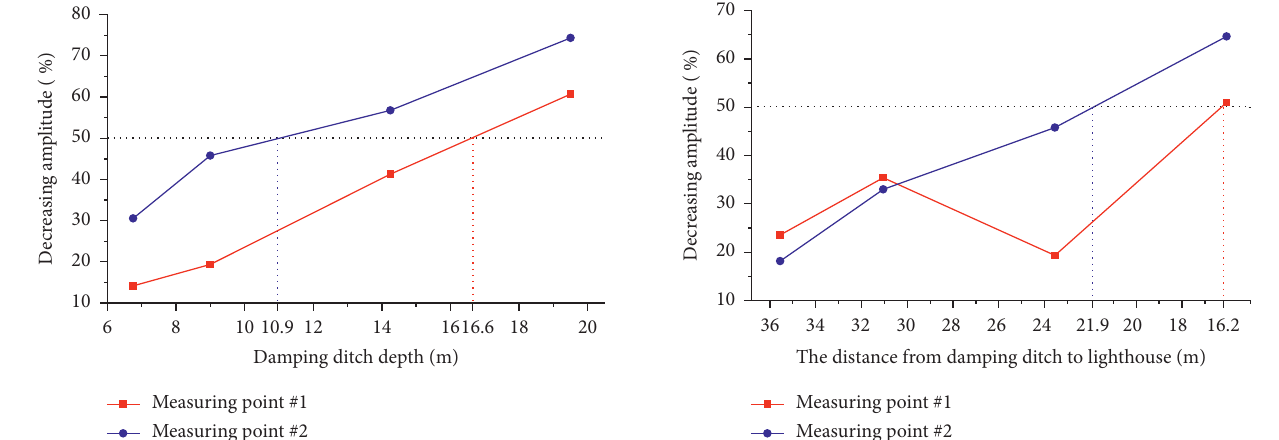
Figure 10: Damping ditch depth versus decreasing amplitude.